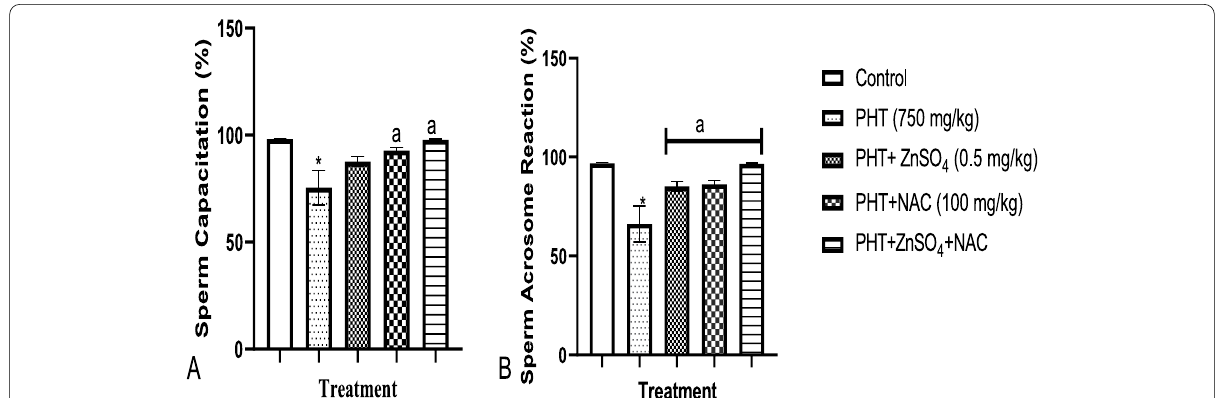
Fig. 3 Effect of treatment with zinc sulfate and N‑acetylcysteine on sperm capacitation and acrosome reaction in phthalate‑treated male Wistar rats. Values are expressed as mean SEM ( n 5) (one‑way ANOVA followed by Tukey’s post hoc test). PHT phthalate, ZnSO 4 zinc sulfate, NAC ± = N‑acetylcysteine. ⁕ and a were considered statistically significant ( p < 0.05) when compared with the control and PHT‑treated groups respectively